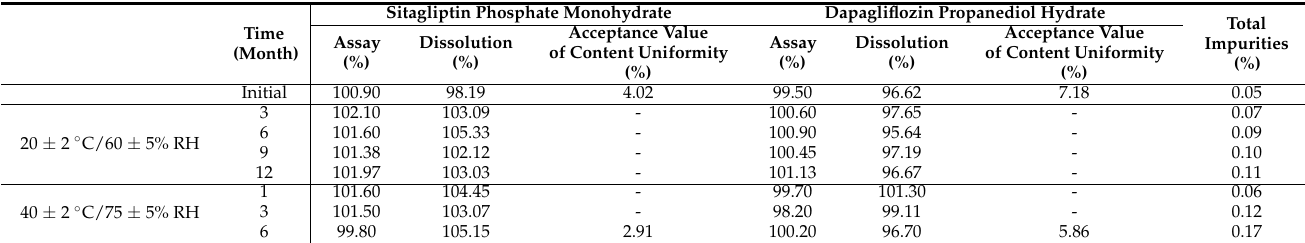
Table 16. Stability test results of sitagliptin phosphate monohydrate-dapagliflozin propanediol hydrate FDC double-layer tablet (F6) ( n = 10).